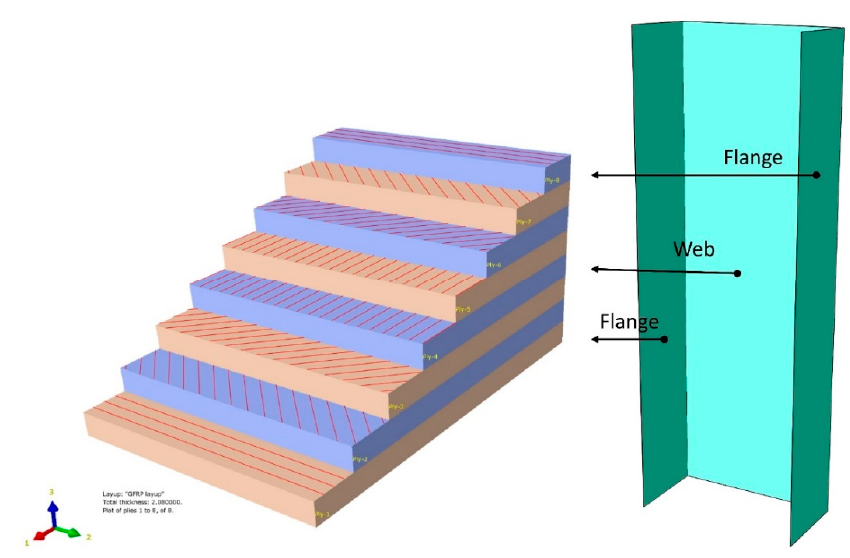
Figure 5. GFRP-laminated plate model in Abaqus.